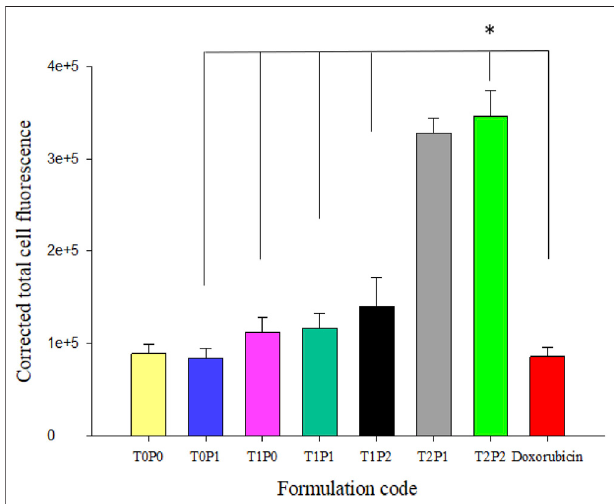
FIGURE 6 | The values of calculated corrected total cell fl uorescence intensity within AD300 cells, based on the outcomes shown in Figure 5 (data present mean ± SD, number of cells counted (cid:1) 30, * p (cid:1) < 0.001).